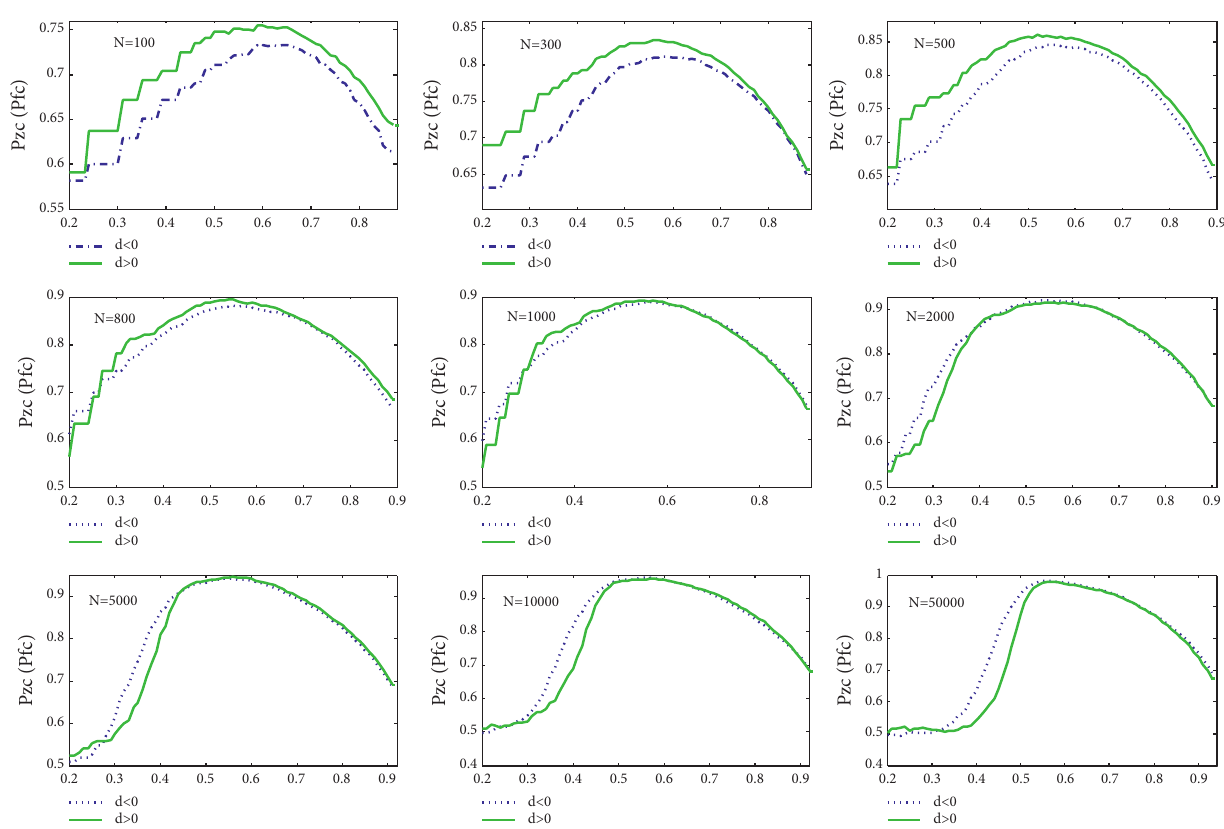
Figure 4: Judging accuracy of persistence and antipersistence long memory.